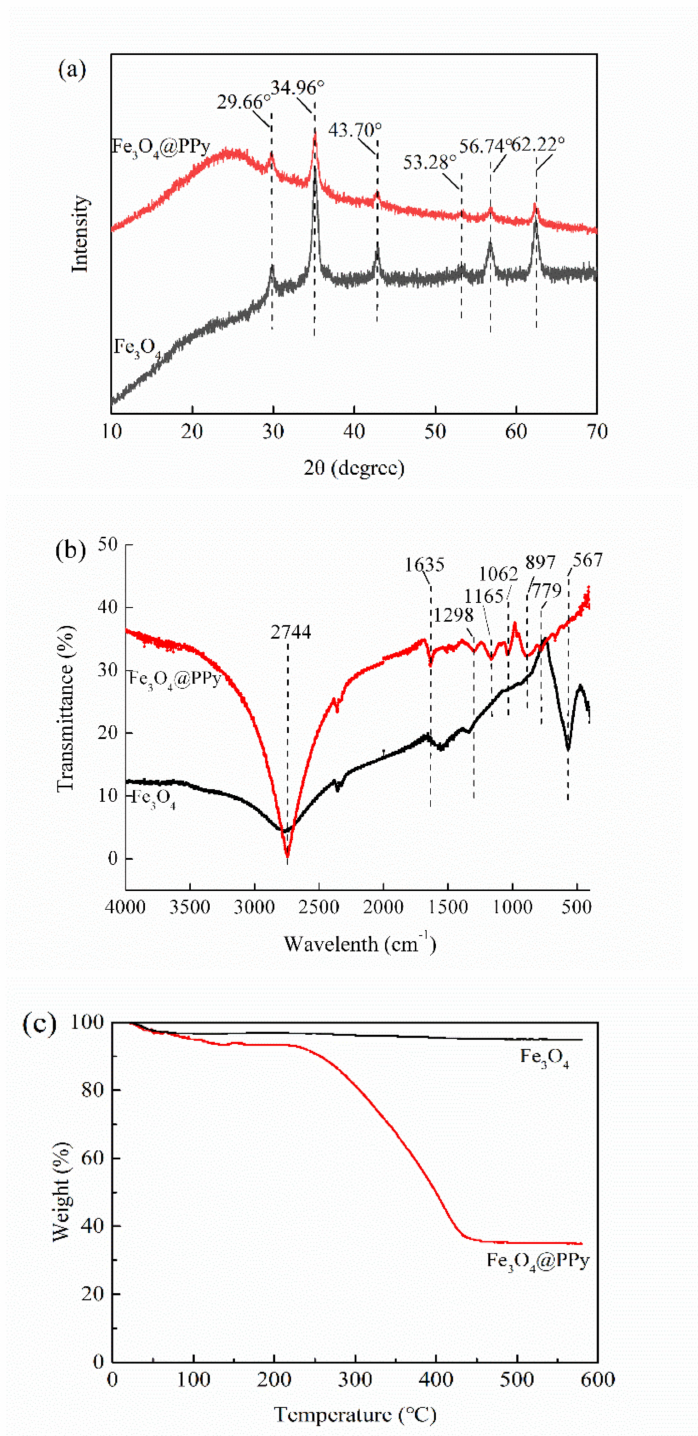
Figure 3. Characteristics of the Fe 3 O 4 @PPy composites compared with Fe 3 O 4 NPs. ( a ) XRD pattern, ( b ) FTIR spectra, and ( c ) TGA